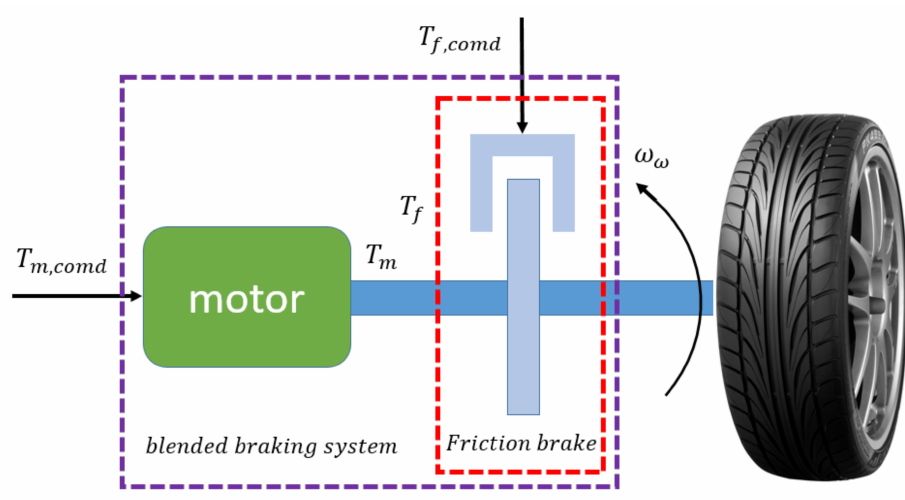
Figure 2. Quarter-vehicle blended braking